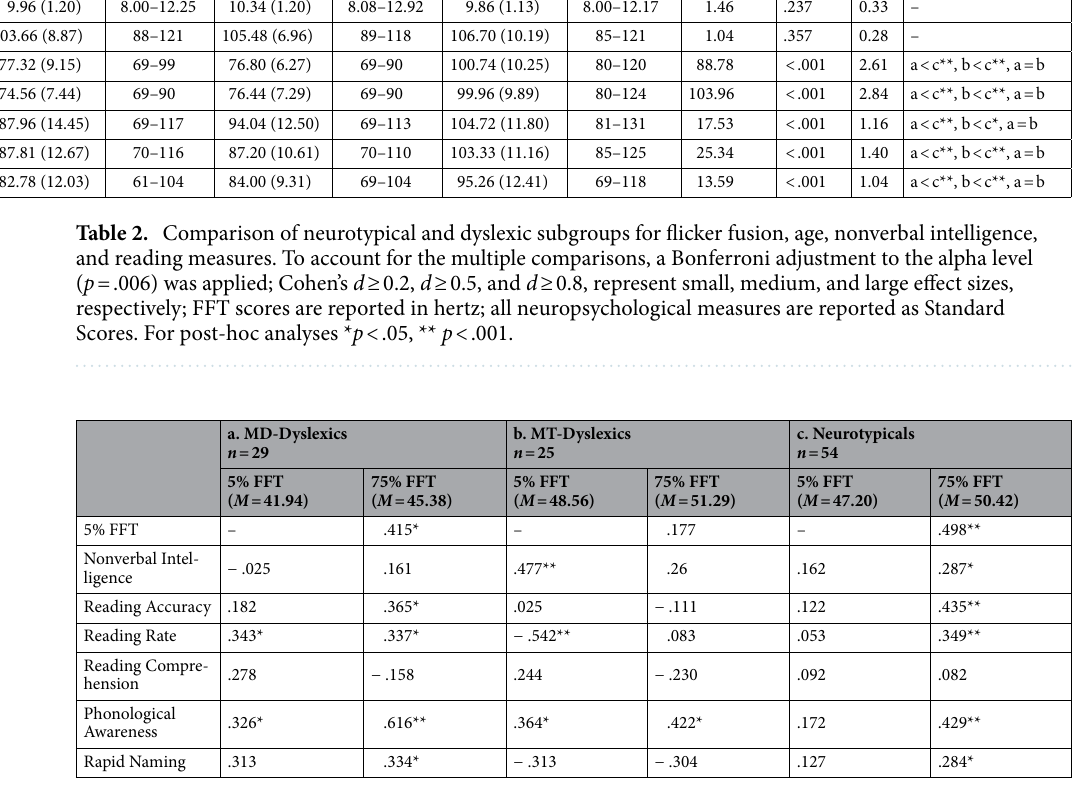
Table 3. Correlations between reading skills and flicker fusion thresholds for each group. * p < .05, ** p < .01; According to Cohen’s guidelines, r ≥ 0.10, r ≥ 0.30, and r ≥ 0.50, represent small, medium, and large effect sizes, respectively 68 ; standard scores are used for all clinical tasks. FFTs are reported in